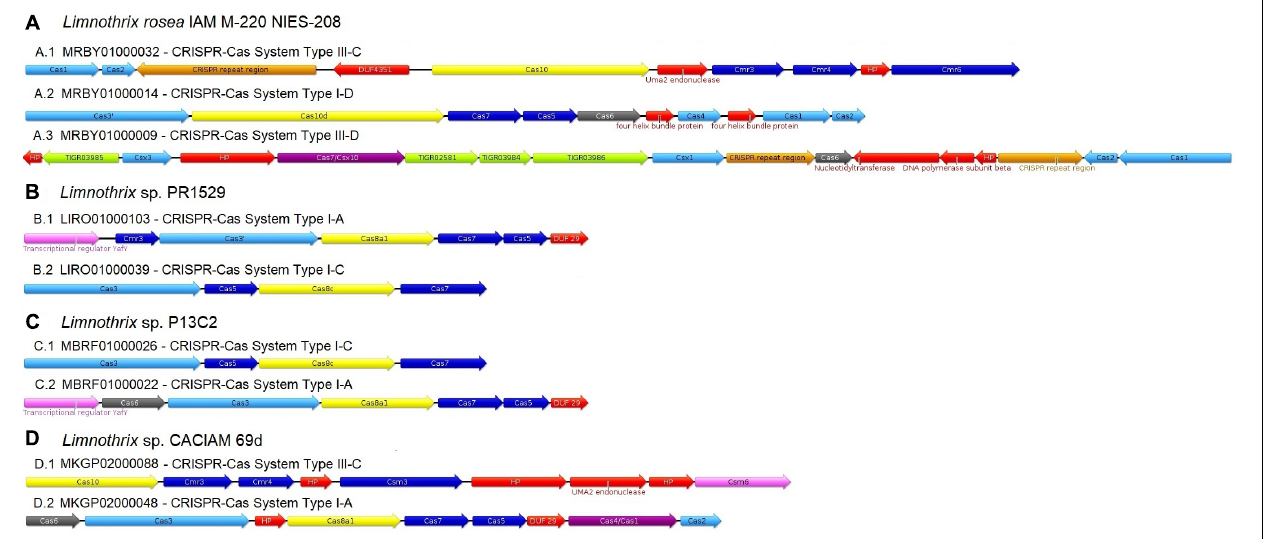
FIGURE 4 | Classification of CRISPR-Cas systems found in all four analyzed Limnothrix genome (A–D) . The colors indicate the following categories: repeat-associated mysterious protein (RAMP) family RNases involved in crRNA process (gray), CRISPR-Cas protein with no major category (light blue), large CRISPR-associated complex for antiviral defense (Cascade) subunits (yellow), RAMP Cascade subunits (dark blue), fused Cas protein (purple), transcriptional regulator (light pink), protein containing a CRISPR-associated domain (green), CRISPR repeat region (orange) and domain of unknown function (DUF) or hypothetical protein (HP) or other (red).